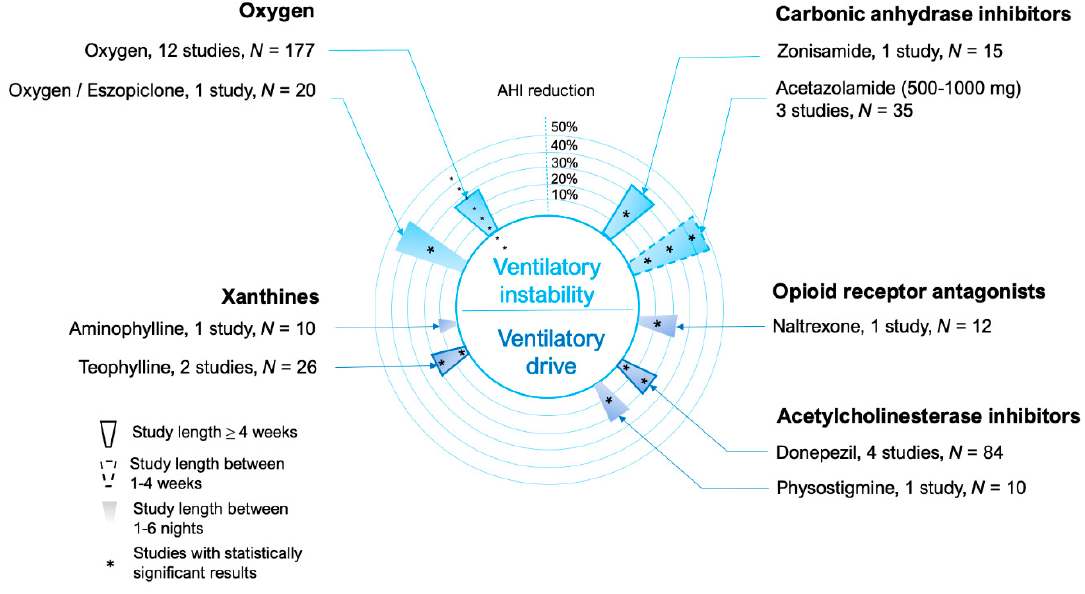
Figure 5. Circular bar plot describing the studies performed using medications that modify ventilatory instability (loop gain) or ventilatory drive. Drugs targeting more specifically ventilatory control instability (loop gain) are represented in the upper part of the circle, those that act more generically as ventilatory stimulants are represented in the lower part of the circle.